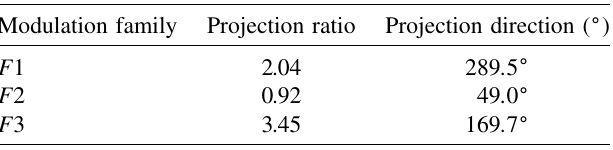
TABLE I. One example of coupling measurements at injec- tion.